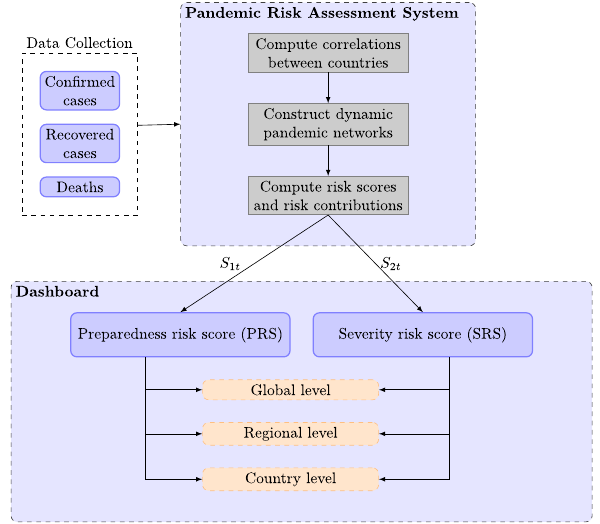
Figure 1. The pandemic risk assessment system work flow